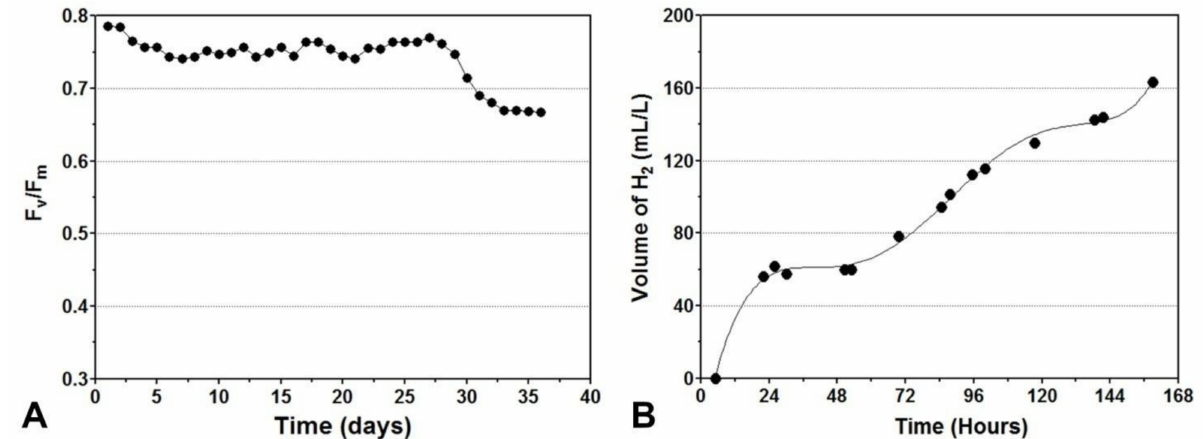
Figure 3. ( A ) F v /F m of immobilized Chlorella vulgaris cells as a function of time; ( B ) H 2 production of the immobilized Chlorella vulgaris cells as a function of